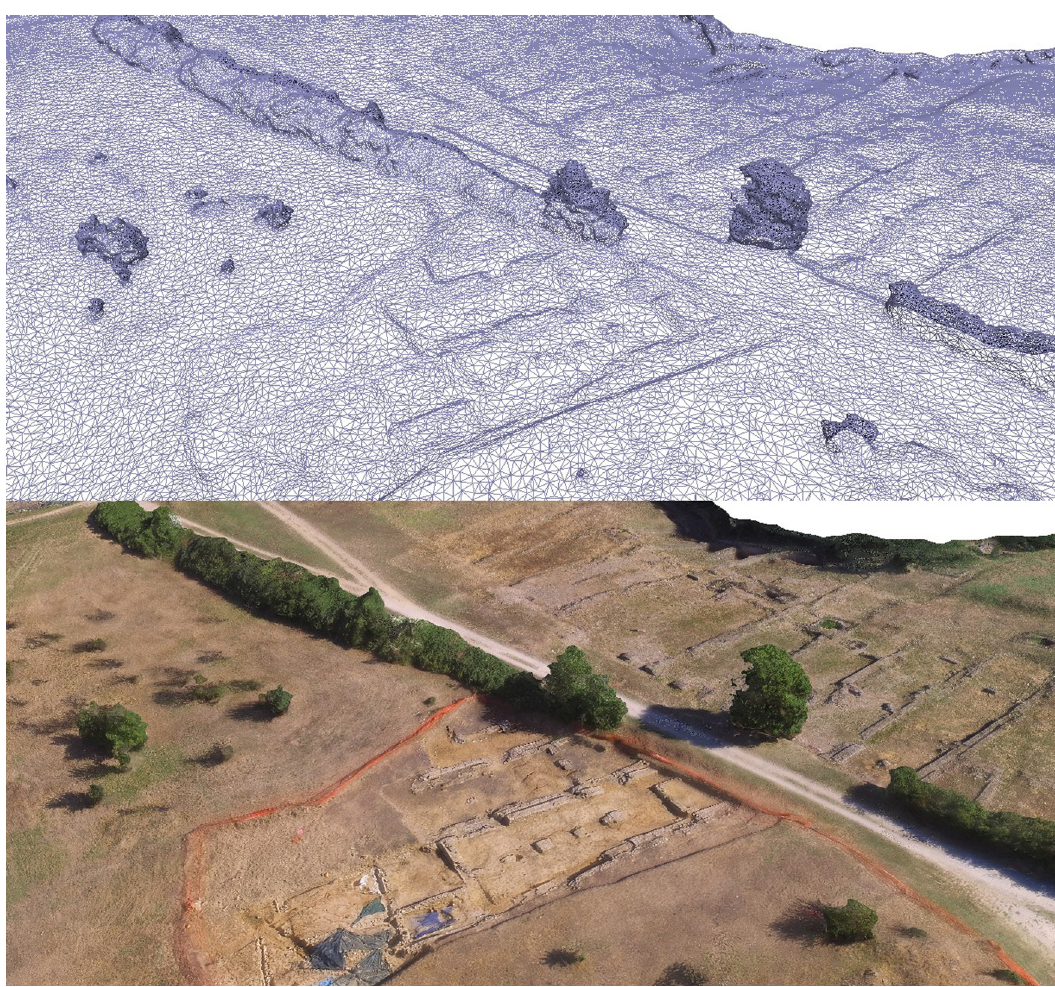
Figure 5: Photogrammetric survey of the archaeological